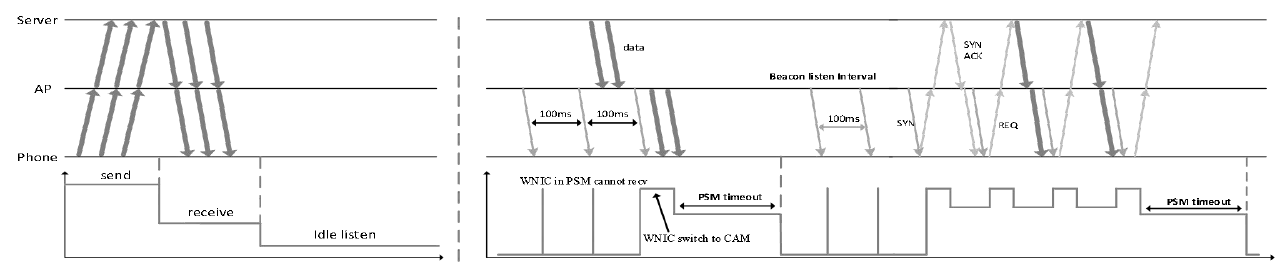
Fig. 1. Continuous Awake Mode(left) and Power Save Mode(right) Figure 1. Continuous Awake Mode(left) and Power Save Mode(right)